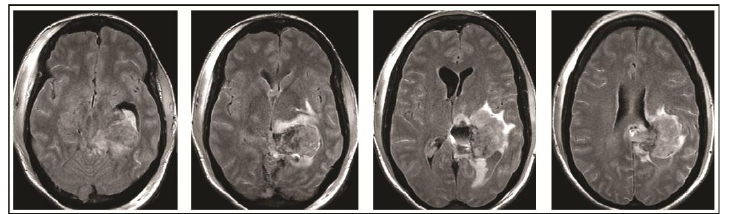
Figure 3. Head computed tomography (CT) performed on post-operative day 3 demonstrates cerebral Figure 2. Post-operative day 1 MRI demonstrates 50% resection of left lateral ventricle meningioma. Figure 2. Post-operative day 1 MRI demonstrates 50% resection of left lateral ventricle meningioma. Figure 2. Post-operative day 1 MRI demonstrates 50% resection of left lateral ventricle meningioma. edema and hydrocephalus.